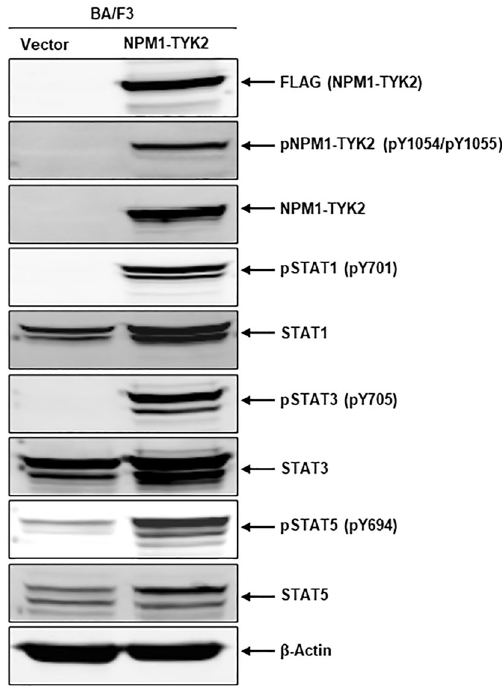
Fig. 2 Fusion kinase NPM1 – TYK2 oncogenic signaling drives the lymphoma cell transformation. Ba/F3-Vector and transformed Ba/ F3 – NPM1 – TYK2 cell lysates were made, subjected to immunoblot analysis for NPM1 – TYK2 (FLAG), phospho-NPM1 – TYK2, phospho- STAT1/3/5, and respective total proteins. β -Actin served as an internal control.